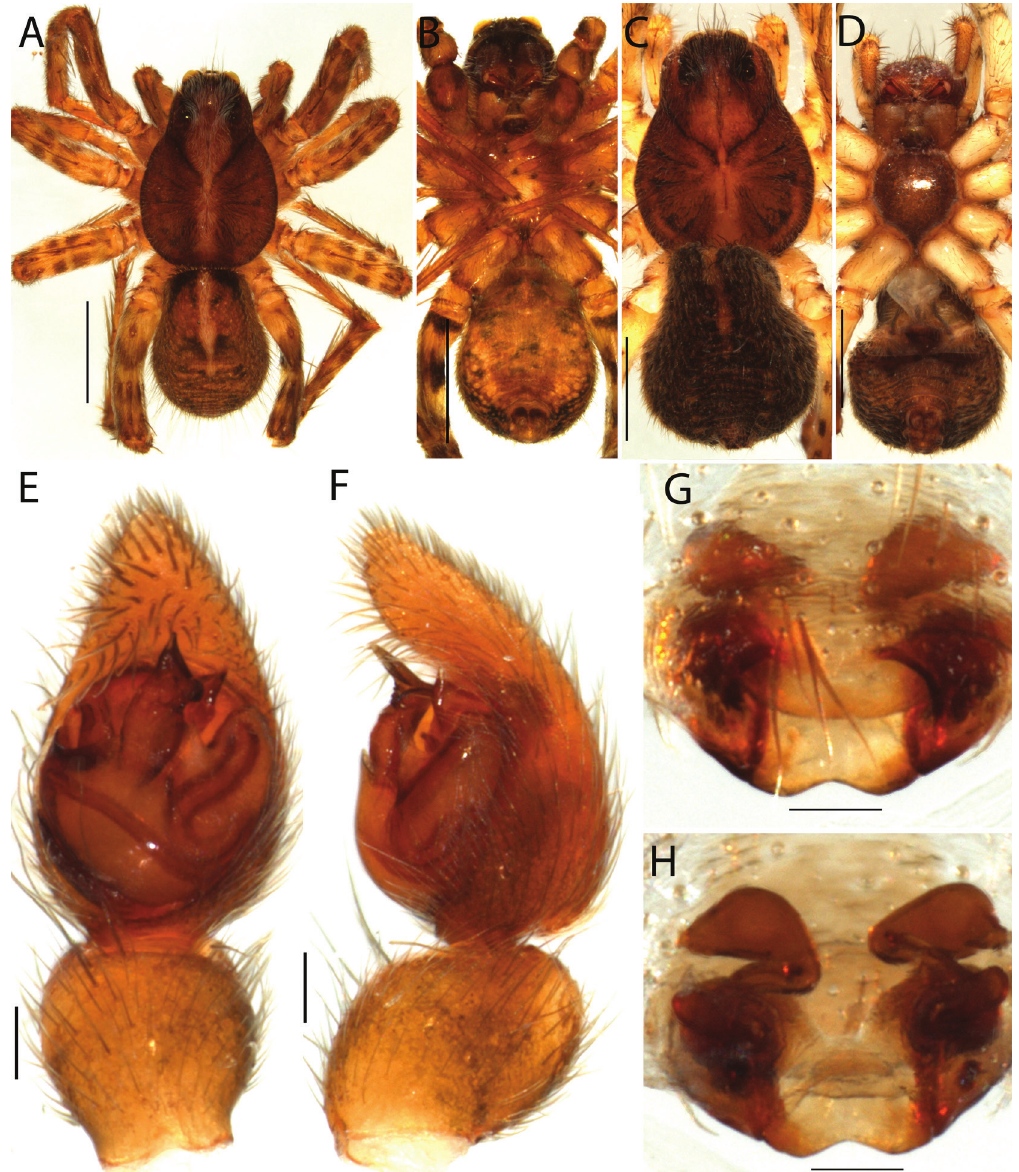
Figure 40. Artoria triangularis Framenau, 2002, male (AM KS99035), female (AM KS117679): A , male habitus, dorsal view; B , male habitus, ventral view; C , female habitus, dorsal view; D , female habitus, ventral view; E, male pedipalp, ventral view; F , female pedipalp, retrolateral view; G , epigyne, ventral view; H , epigyne, dorsal view. Scale bars: habitus 1.0 mm; pedipalp, epigyne 0.1